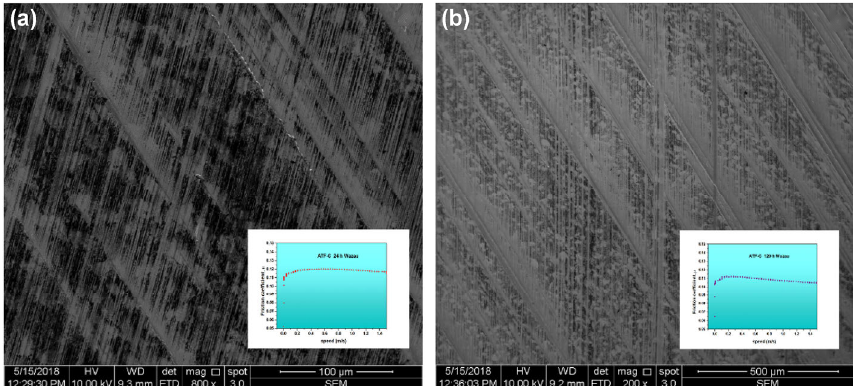
Fig. 5 SEM images of post-test steel disc surfaces after (a) 24 h and (b)120 h Wazau durability tests for